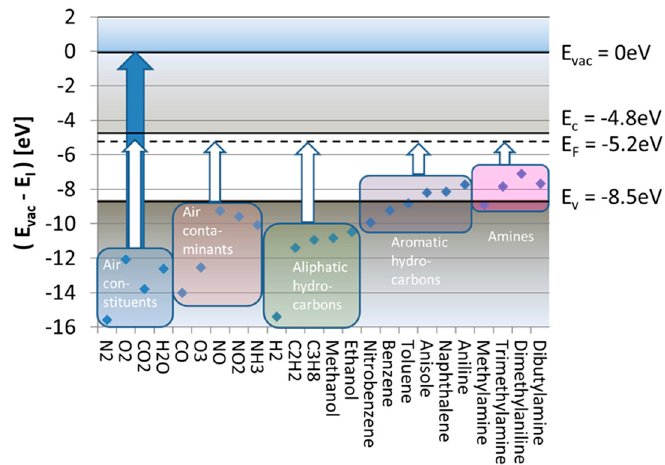
Figure 2. Free-space ionization energies, E I , of selected molecules relative to the vacuum energy, E vac (data redrawn from [19]). Blue arrows denote energy inputs for free-space ionization. White arrows denote energy inputs necessary to induce ionization after the molecules have become adsorbed on a SnO 2 emitter surface. Colored rectangles denote different groups of analytes.